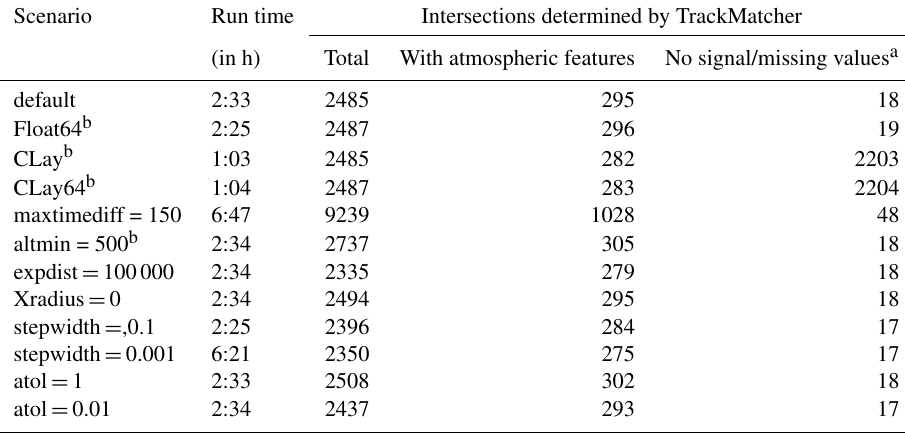
Table 5. Run times and the number of identified intersections for various sensitivity studies. The first column lists parameter settings. Float64 means all input data are loaded in double precision, and CLay means satellite data are loaded as layer data rather than profile data, with the additional condition of loading input in double precision in scenario CLay64. Parameters are applied during the calculation of intersections, unless otherwise